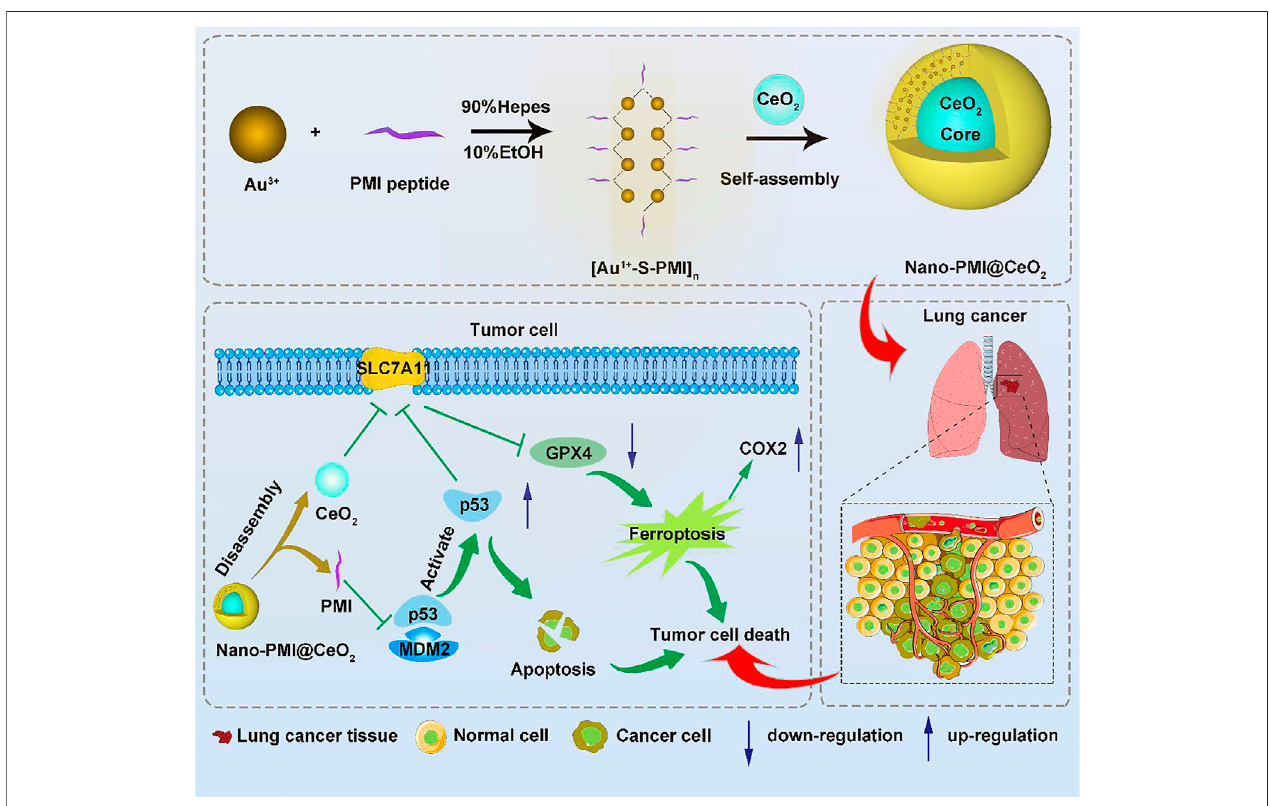
FIGURE 1 | Synthesis and function of Nano-PMI@CeO 2 . Schematic depiction for the synthesis procedure of Nano-PMI@CeO 2 and their targeting in the lung cancer site by EPR effect and p53 pathways inducing ferroptosis.